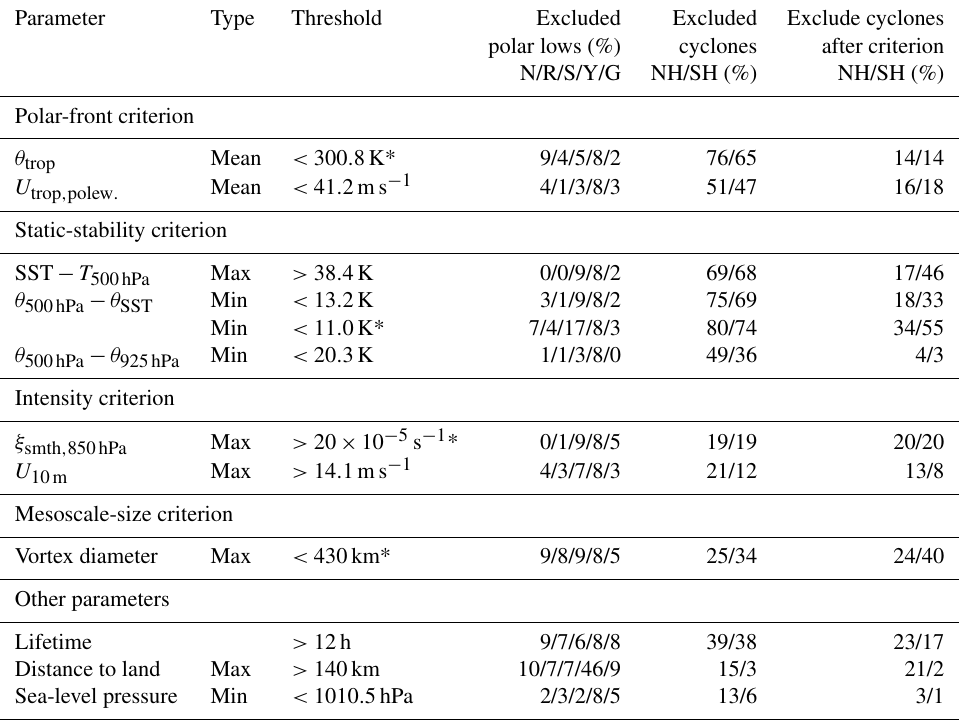
Table 2. Statistics for the derivation of the polar-low criteria. The type expresses whether the parameter is computed as a lifetime mean, maximum, or minimum of a track. The threshold is chosen such that it is satisfied by 90% of the polar lows of all five lists. For θ 500hPa − θ SST a second threshold satisfying all polar-low lists beside the one from Smirnova is presented. The thresholds noted with an asterisk mark the polar-low criteria. Column 4 expresses the fraction of polar lows from the five lists excluded by the threshold. Column 5 provides the fraction of cyclones excluded by the threshold. The last column displays the additionally excluded cyclones by the threshold after the application of the polar-low criteria of different types. The different types of criteria are separated by vertical lines and labelled with headlines. Utilized abbreviations are the following. N: Noer, R: Rojo, S: Smirnova, Y: Yanase, G: Golubkin, NH: Northern Hemisphere, SH: Southern Hemisphere.